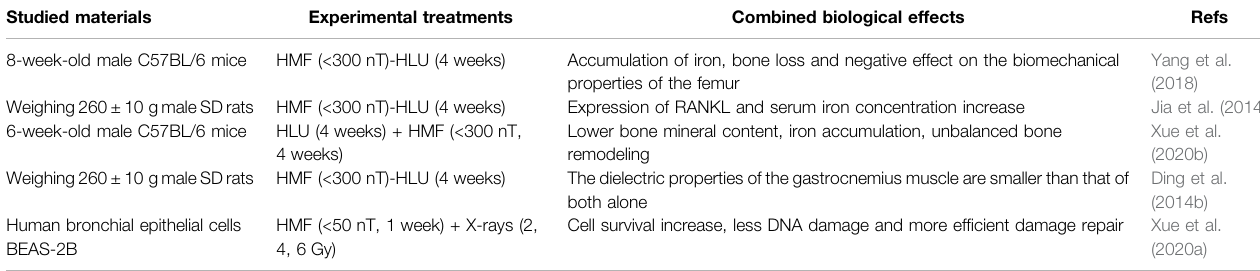
TABLE 2 | Studies reporting combined biological effects of hypomagnetic fi eld and microgravity in mammals. Studied